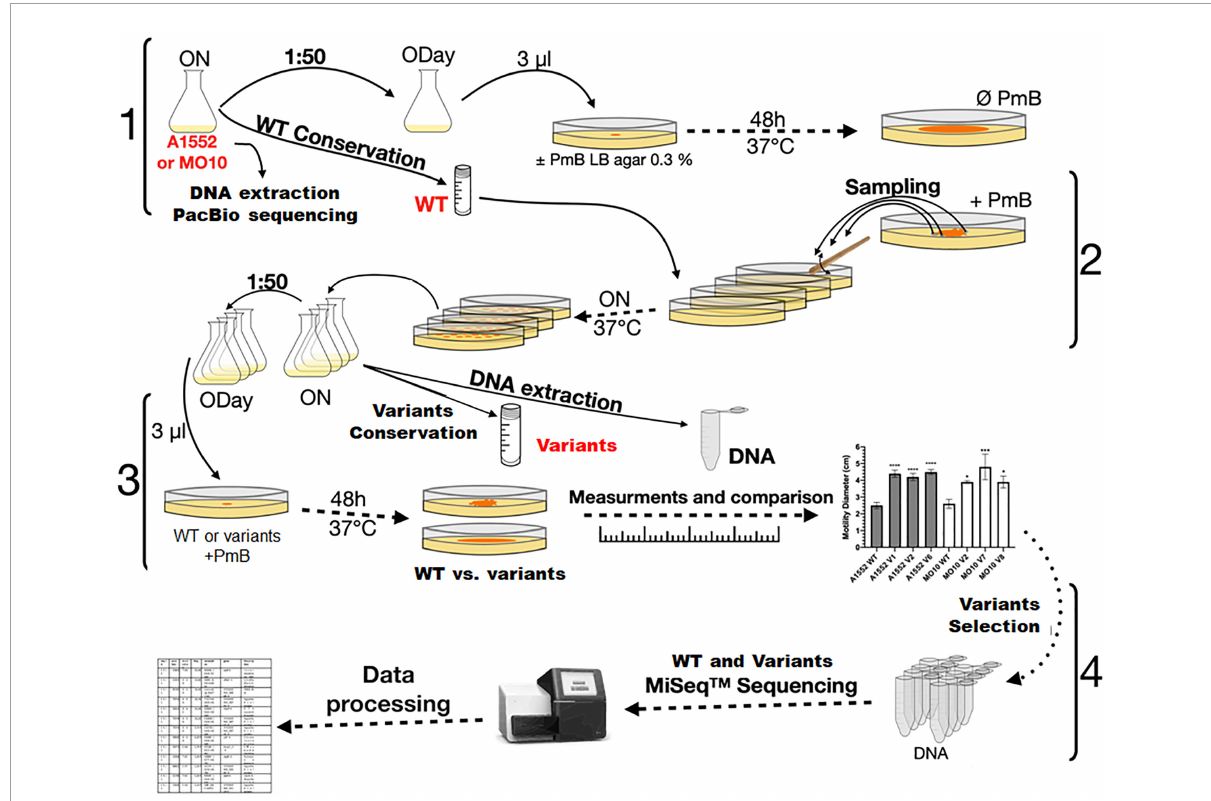
FIGURE2 Experimental evolution design. V. cholerae A1552 and MO10 strains were grown overnight in LB broth. Genomic DNA from both strains was extracted and sequenced by Pac Bio. After dilution, the bacteria were grown to an optical density at 600 nm (OD 600 nm ) of 0.3 (ODay). Aliquots were spotted in technical triplicates on soft LB-agar supplemented or not with PmB. After incubation, samples of the different strains were taken from the edge of different protuberances of the flower-like patterns and streaked on LB agar. A colony from each of the different WT strains and their putative variants were grown overnight in LB broth and conserved at –80 ◦ C. The motility of the WT strains and variants was compared on soft agar plates supplemented with PmB. Motility diameters of the variants were measured and compared to those of their respective WT strains. The genomic DNA of selected hypermotile variants was extracted and sequenced by